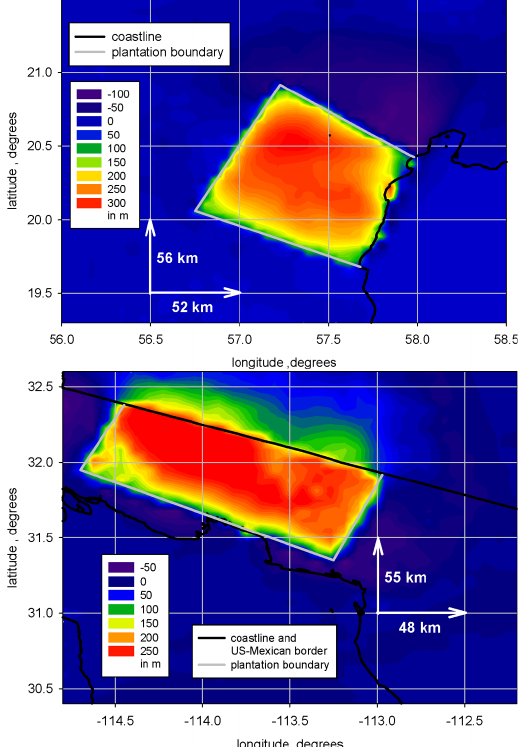
Fig. 5. Mean difference between IMPACT and CONTROL ABL top in summer over Oman (upper panel) and Sonora (bottom panel).